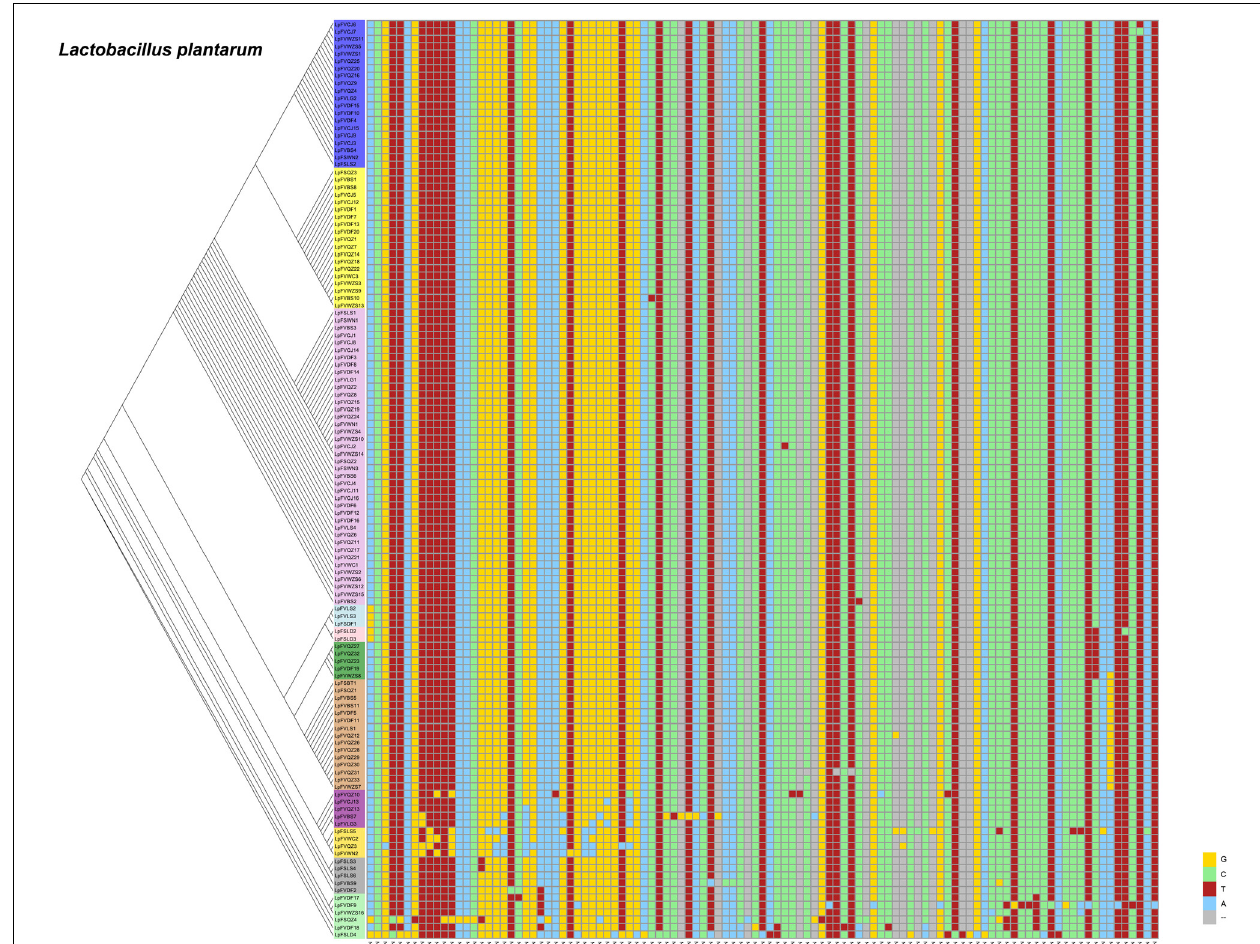
FIGURE 6 | SNPs of Lactobacillus plantarum in the